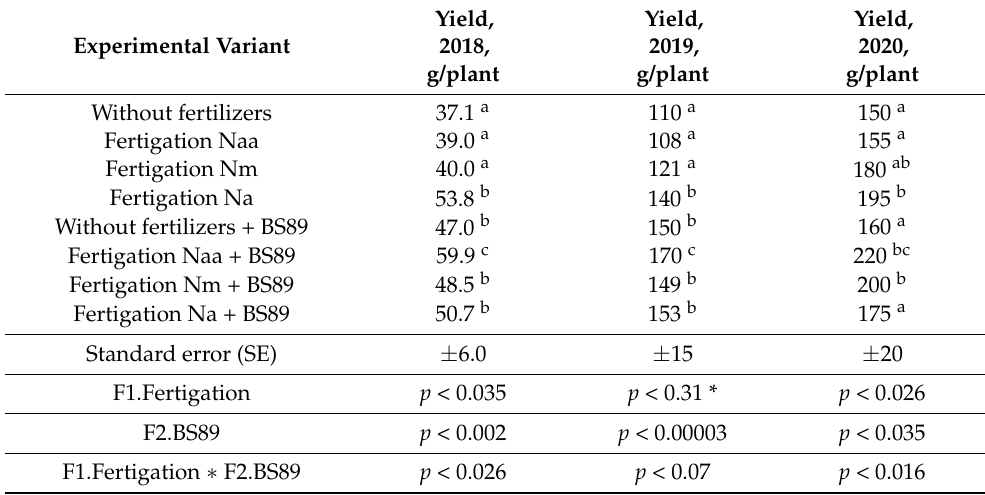
Table 4. Yield of berries of cv. Rusich strawberry plants and ANOVA data.